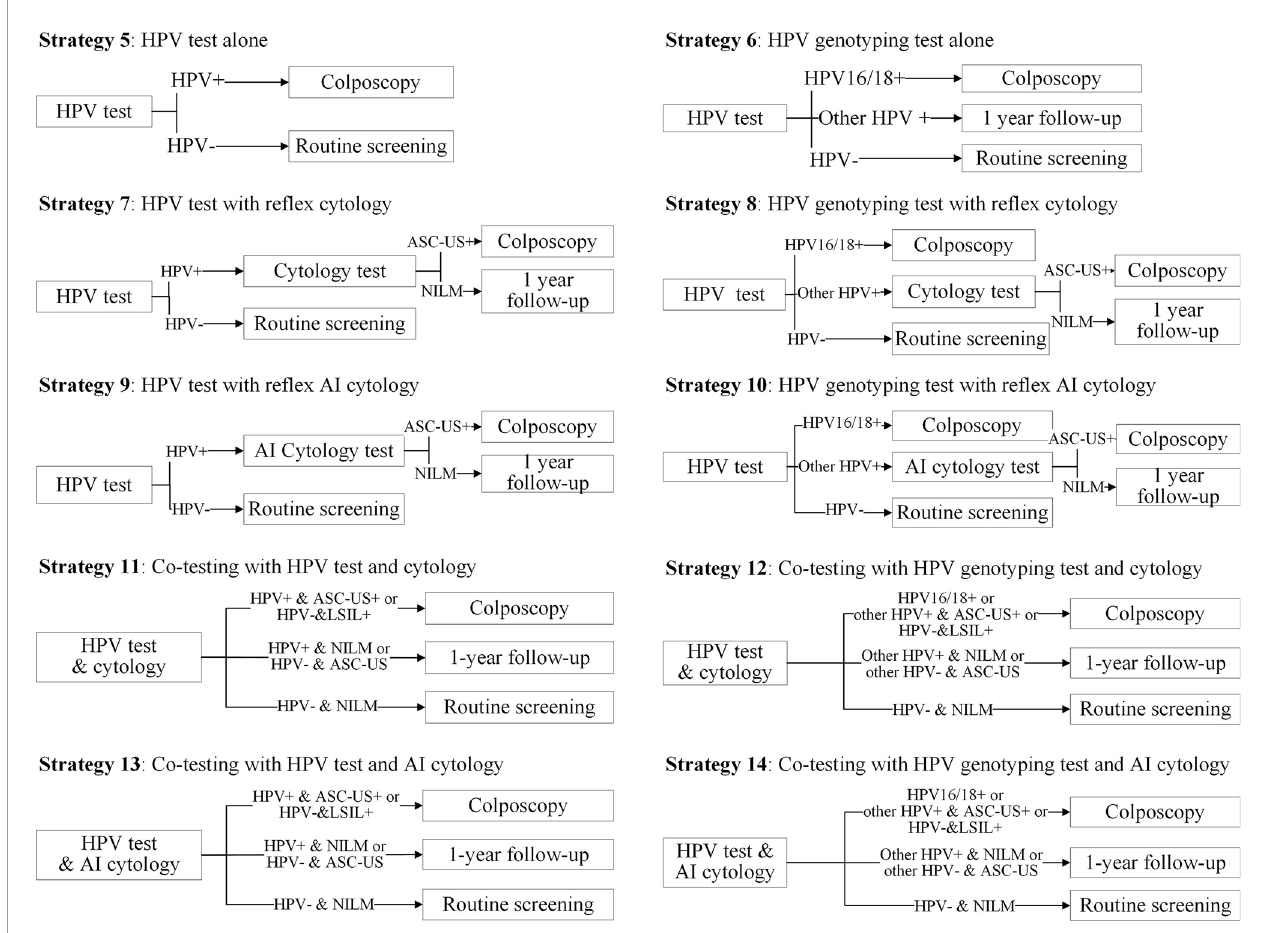
FIGURE 2 | Primary HPV screening strategies and co-testing strategies in the study. HPV, human papillomavirus; ASC-US, atypical squamous cells of undetermined signi fi cance; LSIL, low-grade squamous intraepithelial lesion; AI, arti fi cial